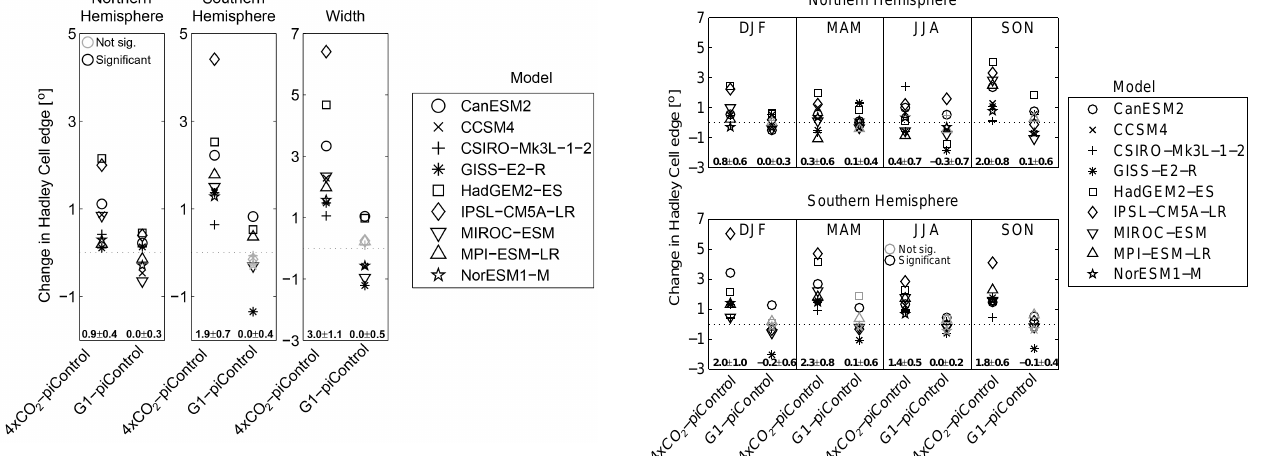
Figure 5. The seasonal change in the Hadley cell edge latitudes and width between the 4 × CO 2 and piControl experiments and be- tween the G1 and piControl experiments, for the Northern Hemi- sphere and Southern Hemisphere edge latitudes. Positive values in- dicate poleward expansion. Models with edge latitude changes sig- nificant at the 95% confidence level are shown in black. Values are shown for December through February (DJF), March through May (MAM), June through August (JJA), and September through November (SON). The mean change in the tropical belt width or edge latitude and its 95% confidence interval in degrees latitude is shown at the bottom of each